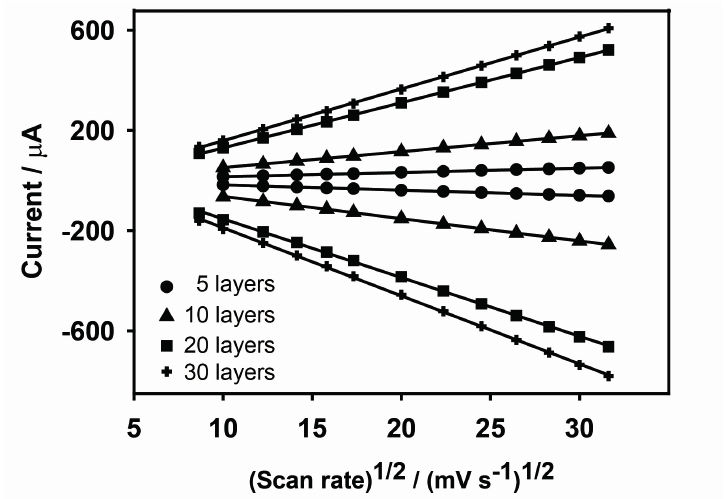
Figure 6. Current vs . square root of scan rate for PBNP-SPEs demonstrating the diffusion-controlled behavior.